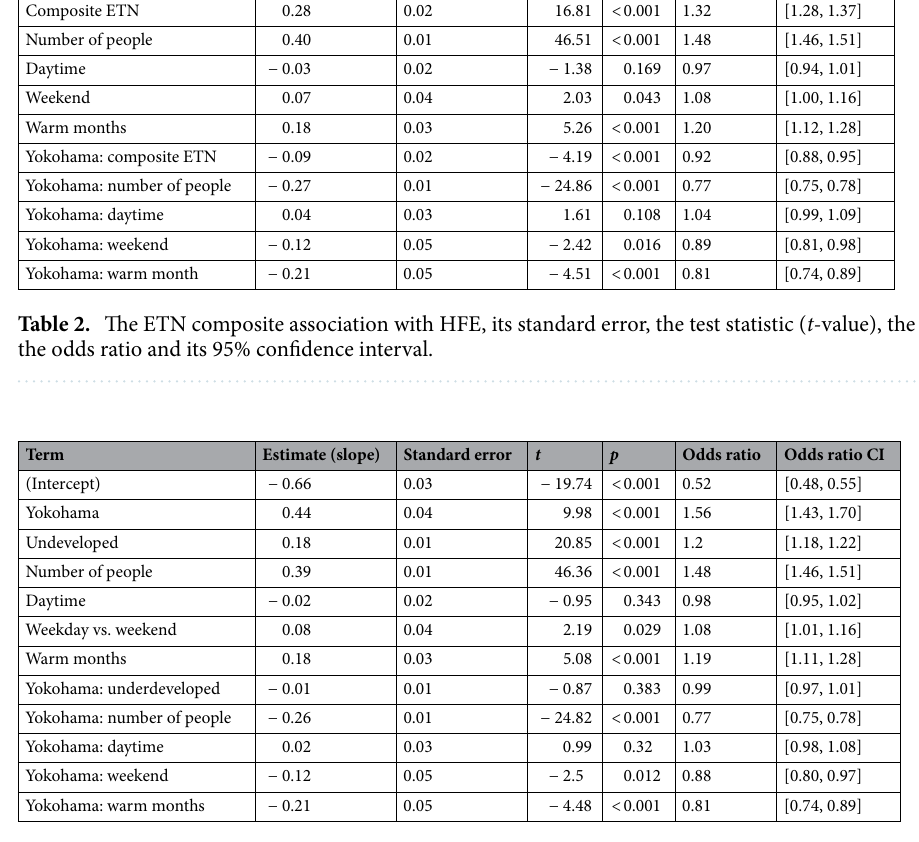
Table 3. The association of less built-up areas association with HFE.